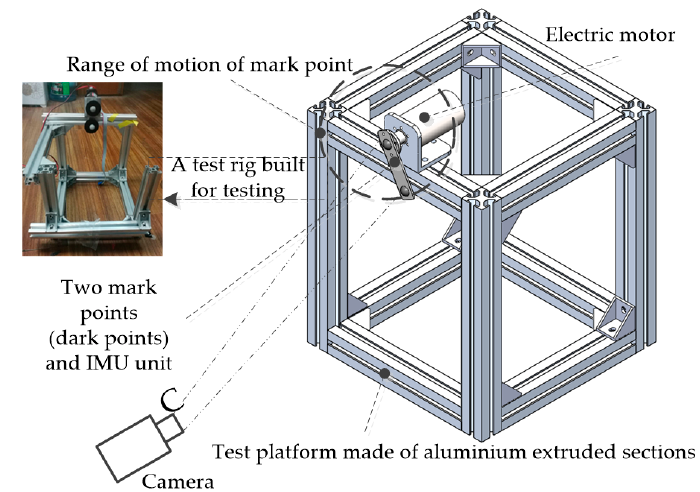
Figure 8. Test platform.